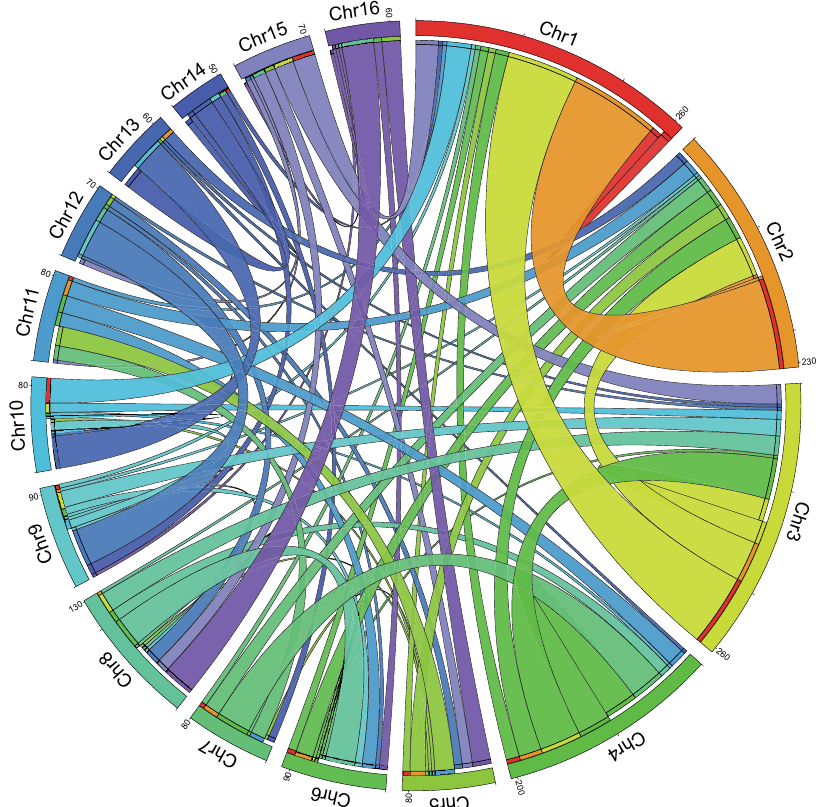
Fig. 7 Paralogous segments in the mangrove HSC genome. Circos plot showing paralogous regions (paralogons) in the mangrove HSC genome. Numbers on the chromosomes represent the number of anchor points, i.e. sets of syntenic paralogous genes. The thickness of the bands is proportional to the number of anchor points shared between two chromosomes. Note that the position of the bands on the chromosome do not indicate the chromosomal location of the anchor points.